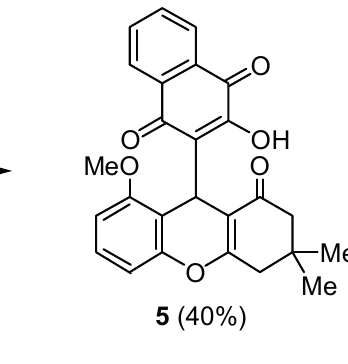
Scheme 3. One-pot synthesis of title compound 5